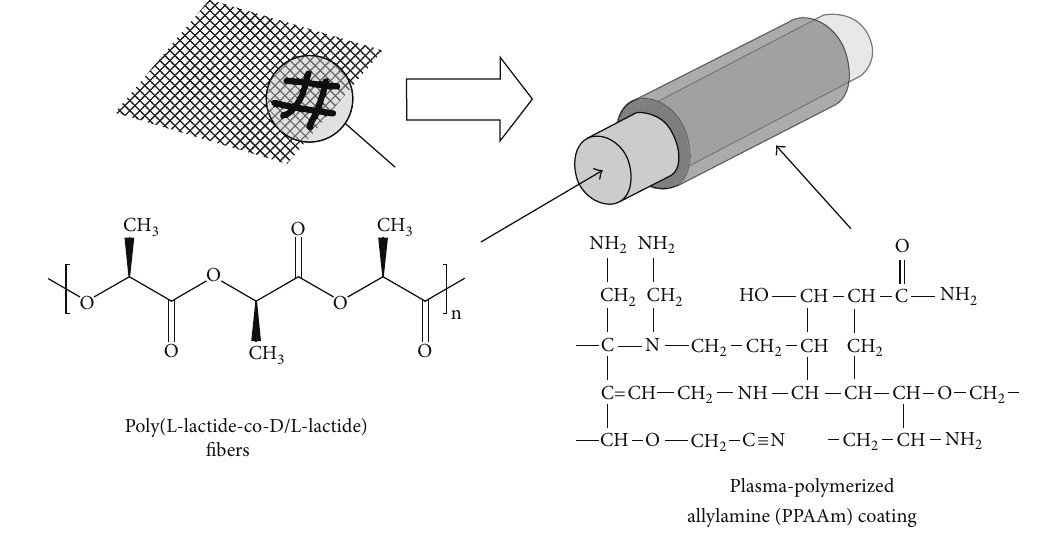
Figure 1: Schematic illustration of surface-coated fiber meshes.